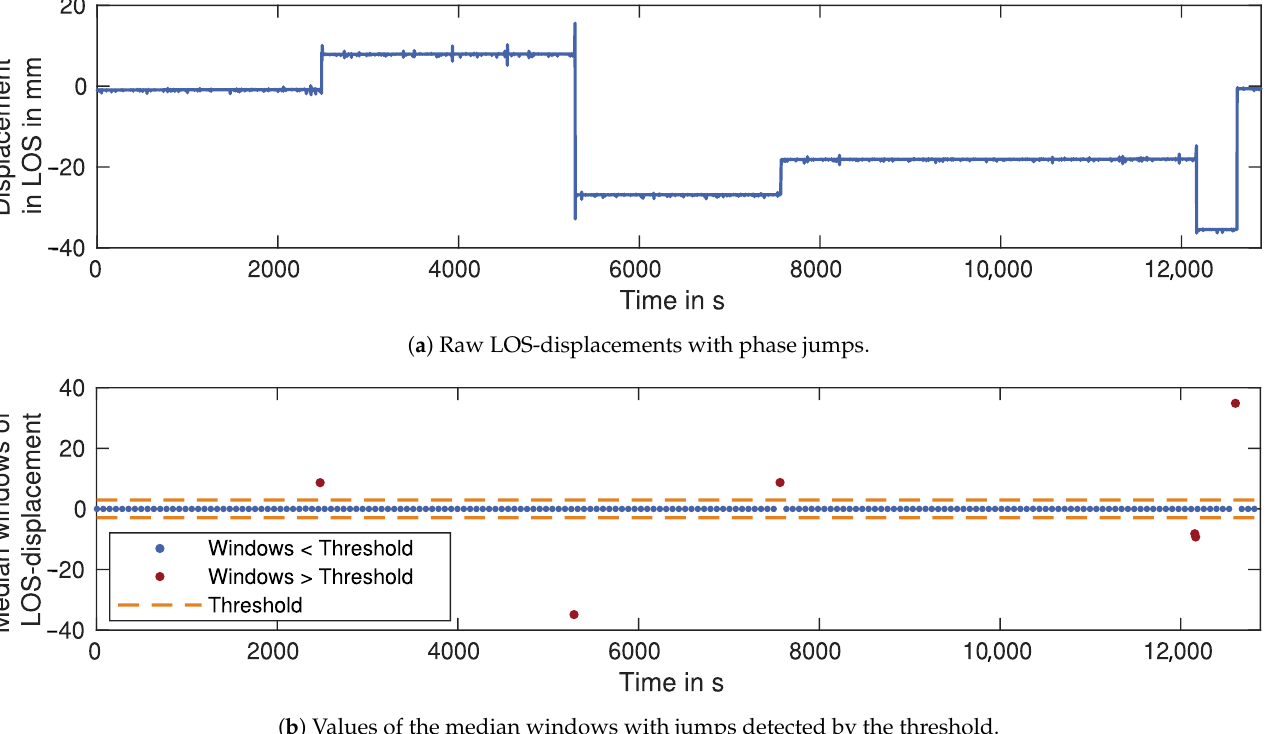
Figure 9. Detection of phase jumps in raw LOS-displacements for Target 1 measured by GBR